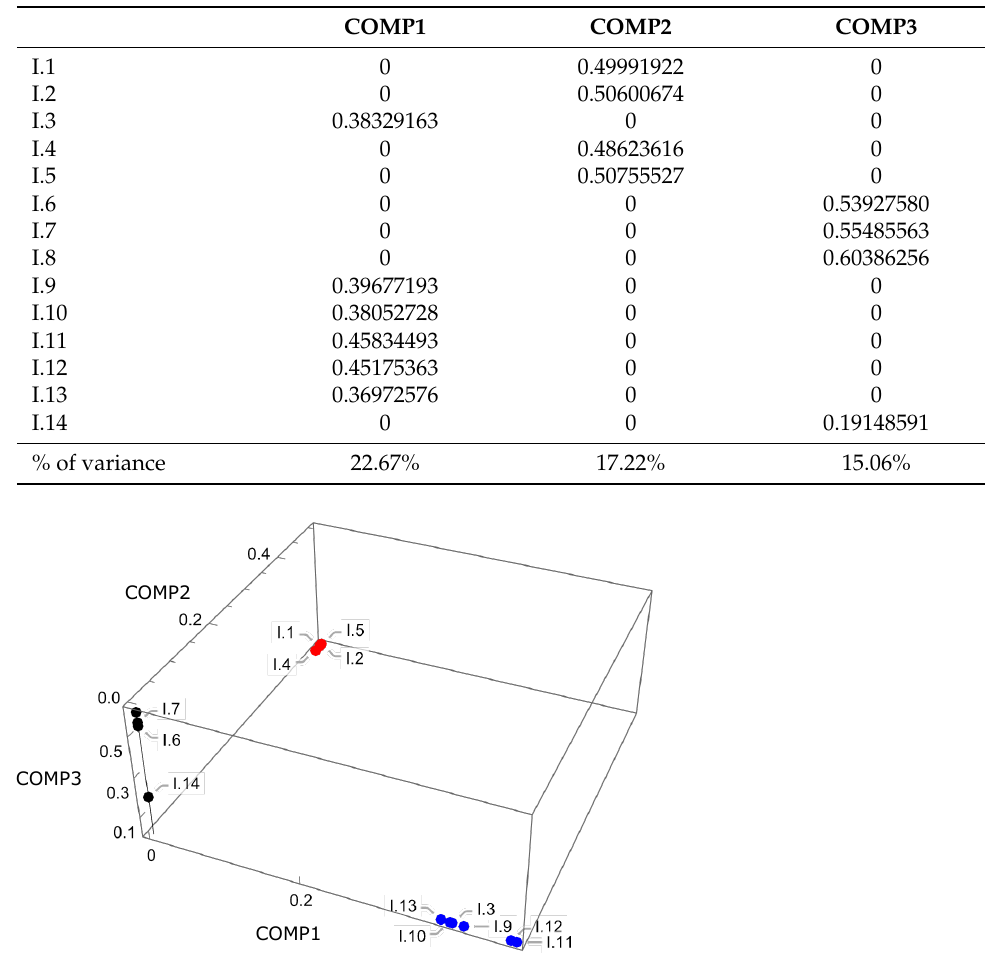
Table 9. Loading matrix of the DPCA with WhatsApp Indian data.